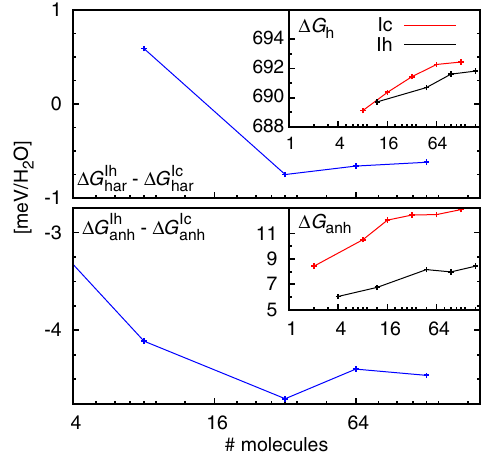
FIG. 6. The harmonic free energy Δ G and anharmonic free har energy Δ G are shown as functions of the simulation cell size in anh the upper and lower panels, respectively. We have investigated the convergence of Δ G and har Δ G with respect to the size of the simulation cell using anh cells containing up to 192 molecules for Ih P 6 3 cm and 128 molecules for Ic P 4 3 as shown in Fig. 6.